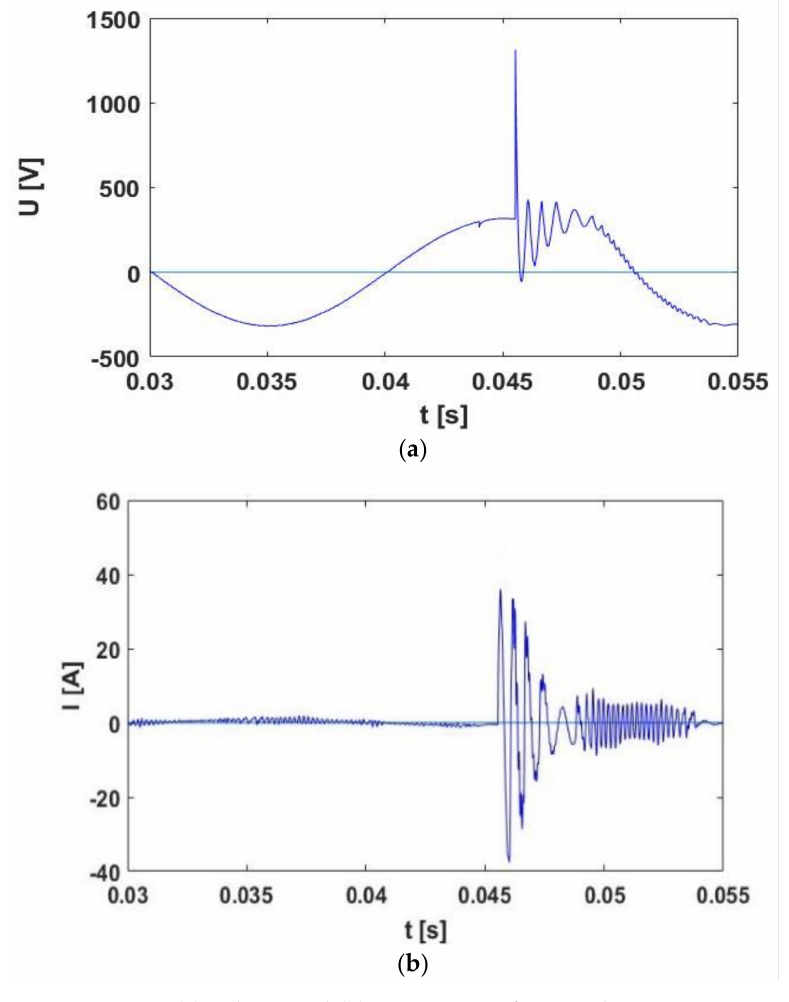
Figure 8. Input ( a ) voltage and ( b ) current waveform in the microinverter section disturbed by voltage surge with positive polarization.